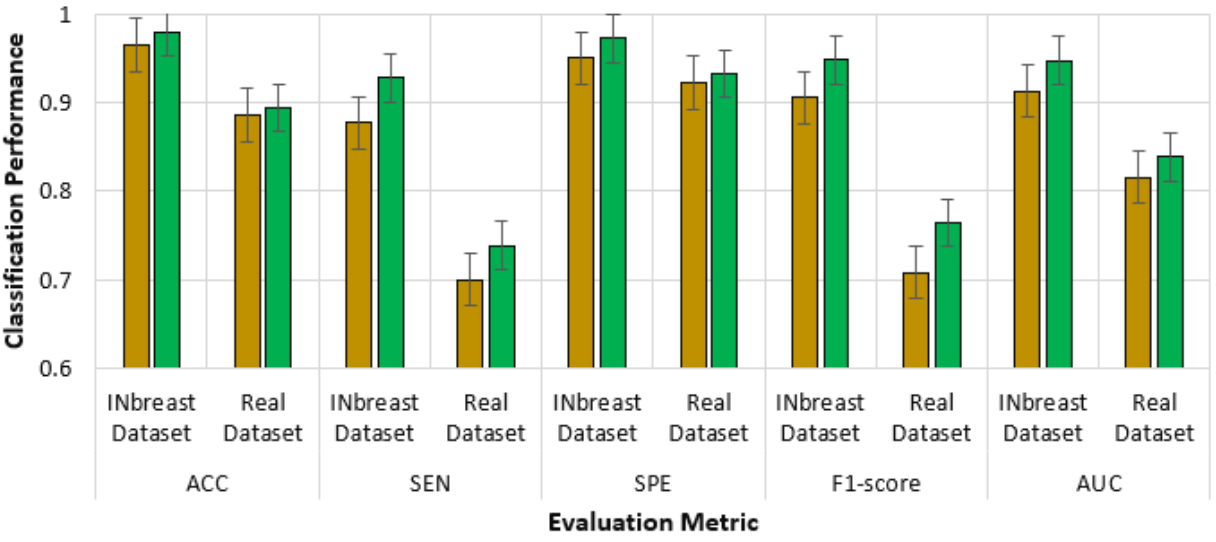
Figure 16. Comparison results of multi-class approach for ETECADx model against the ensemble learning model using both INbreast and real datasets. Table 11. Validation classification results for the multi-classification approach using all AI models in- cluding the ensemble learning and the proposed ETECADx framework. The real unseen dataset (Dataset2-B) is used for this study.